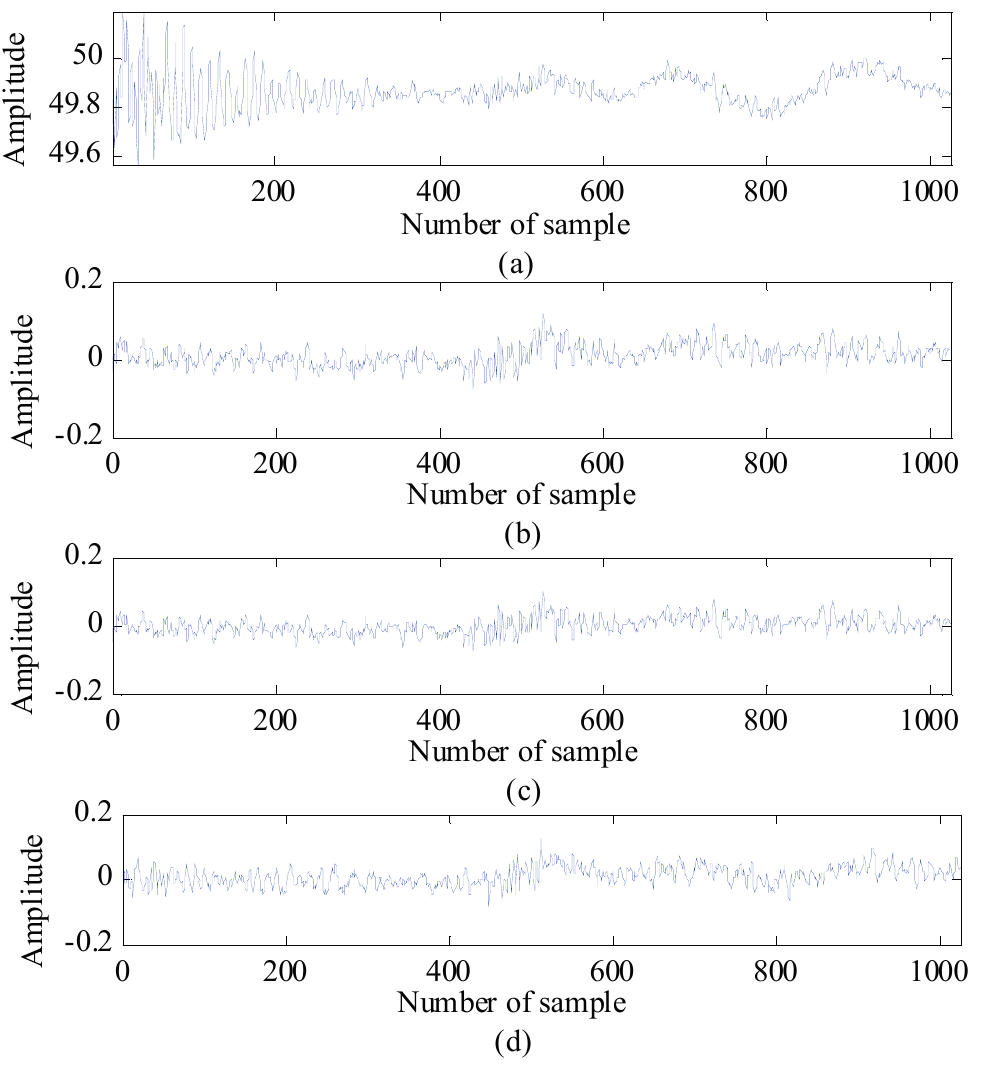
Figure 6. Radar scan: ( a ) before clutter reduction; ( b ) after application of clutter reduction, ( c ) after application of SVD clutter reduction; and ( d ) after application of KF-based clutter